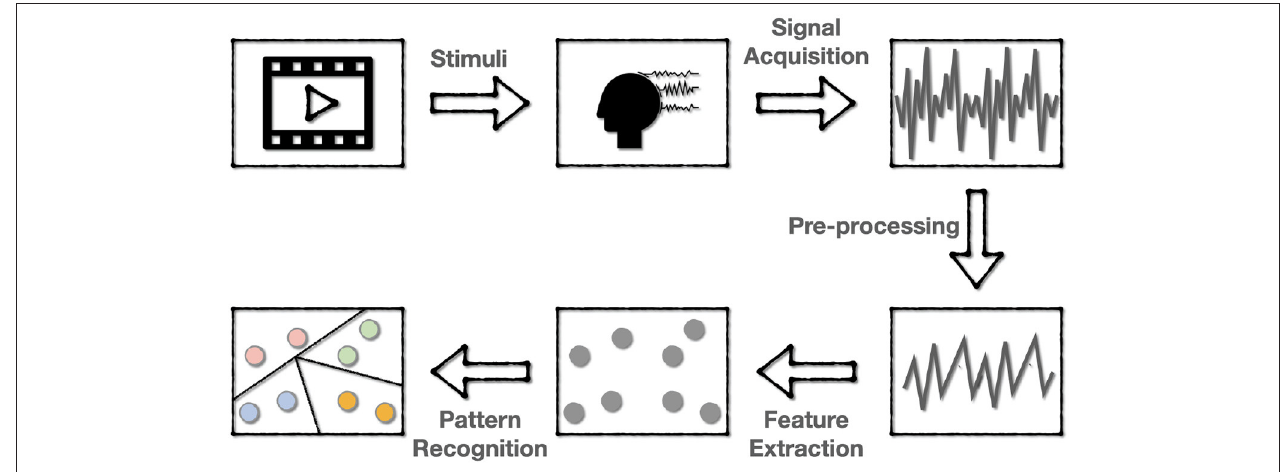
FIGURE 2 | The flowchart of EEG-based BCI for emotion recognition. The emotions are first evoked and encoded into EEG data, then the EEG data are pre-processed and extracted to various forms of features for subsequent pattern